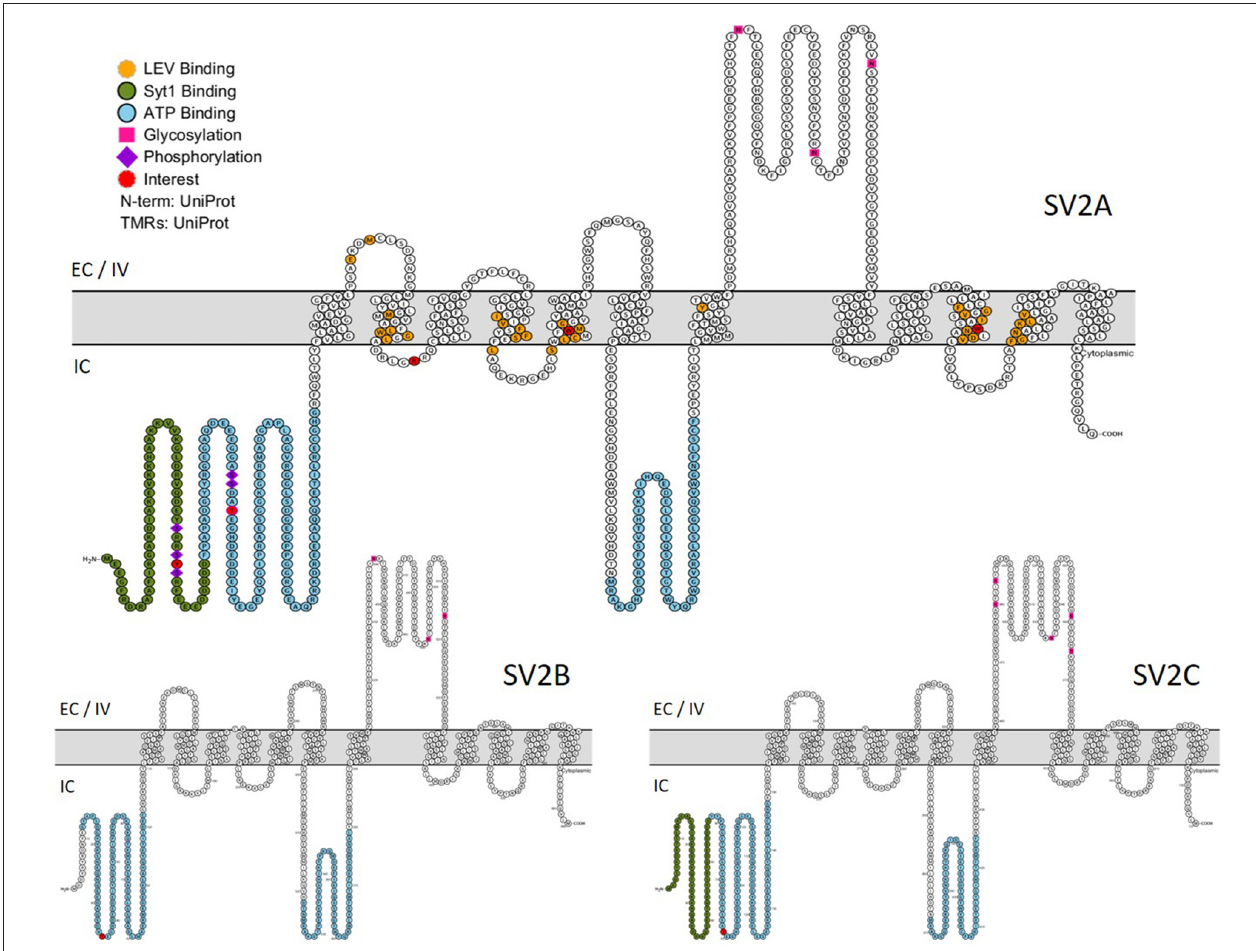
FIGURE 4 | Primary structures of SV2 proteins. In green: Synaptotagmin 1 binding domain. In blue: nucleotide binding domains. In orange: residues implicated in LEV binding. Purple lozenge: phosphorylated residues. Pink square: glycosylated residues. In red: residues of particular interest. EC, Extracellular; IV, Intravesicular; IC, Intracellular. (This figure was built using